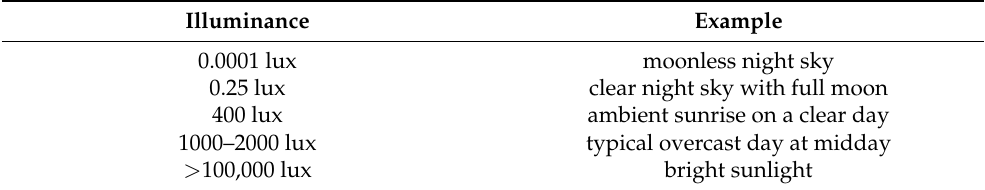
Table 1. The comparison with different lighting conditions [41] allows us to interpret the CAVE’s conditions and gives an impression of its maximum